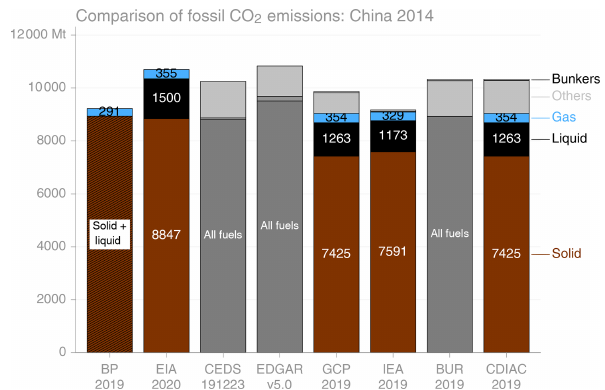
Figure 12. Comparison of fossil CO 2 emissions from seven sources for